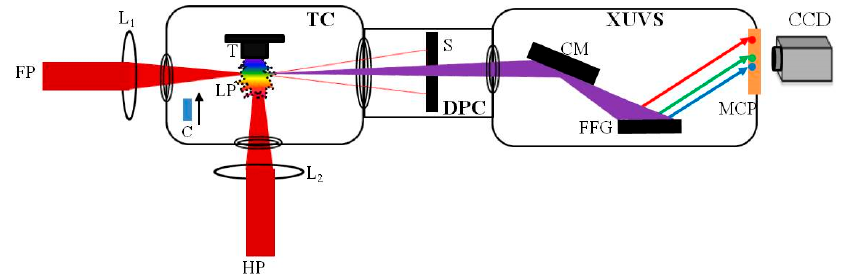
Figure 1. Experimental setup for high-order harmonic generation in LPPs. FP, converting femtosecond pulses, HP, heating pulses; L 1,2 , focusing lenses; TC, target chamber; T, target; C, BBO crystal; LP, laser plasma; S, slit; DPC, differential pump chamber; XUVS, extreme ultraviolet spectrometer; CM, cylindrical gold-coated mirror; FFG, flat field grating; MCP, micro-channel plate; CCD, CCD camera.